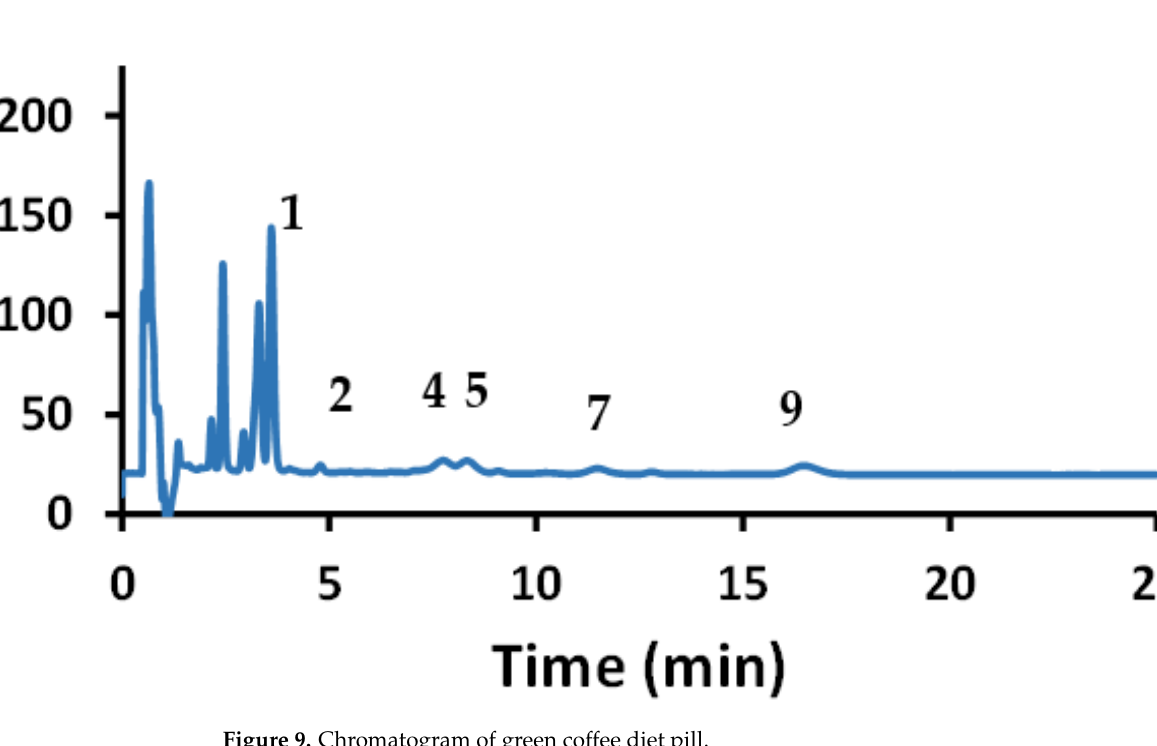
Figure 8. Chromatogram of red wine sample (lower black trace) and spiked red wine to 20 mg/L of the HCAs (upper orange trace).